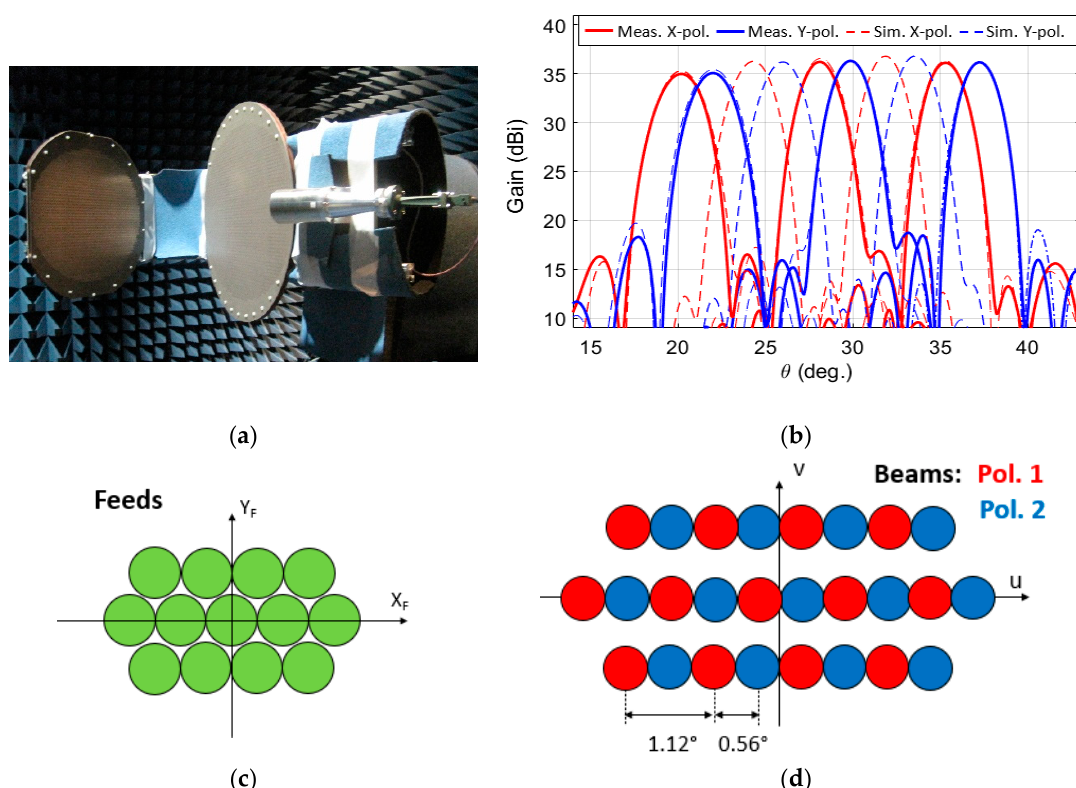
Figure 1. ( a ) Manufactured bifocal dual-reflectarray antenna (DRAA) demonstrator, ( b ) simulated and measured radiation patterns at 19.7 GHz of the 10 beams produced by 5 adjacent horns operating in dual polarization, ( c ) feed cluster and ( d ) beam configuration associated to the bifocal DRAA proposed in [20].